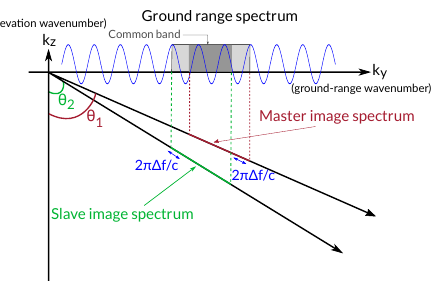
Figure 1. Illustration of the wavenumber shift